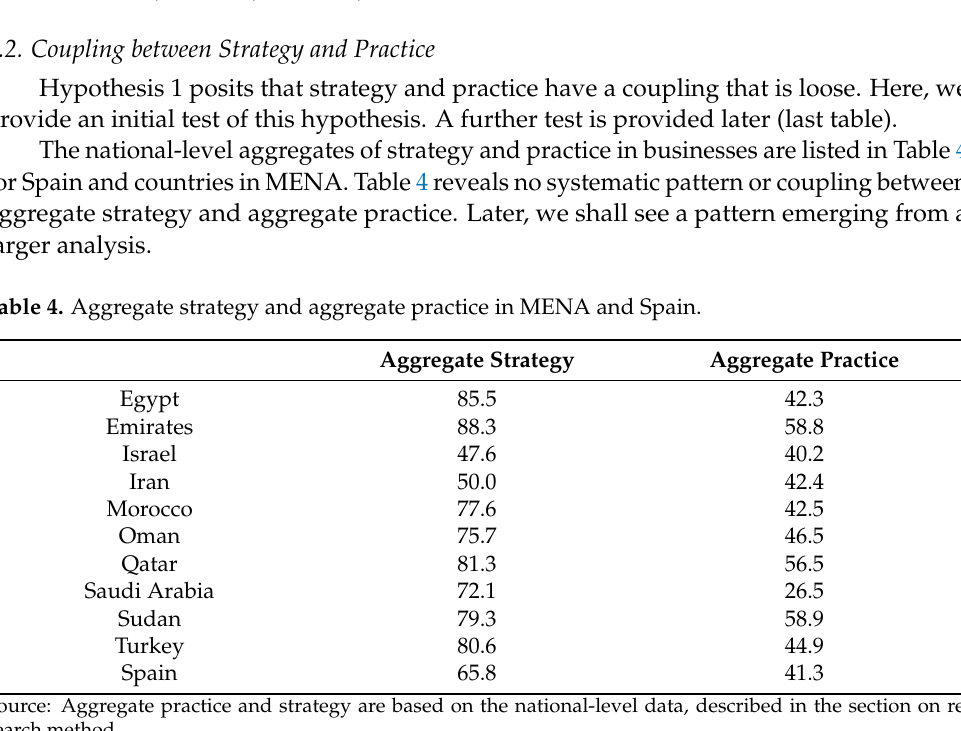
Aggregate Aggregate Practice Strategy